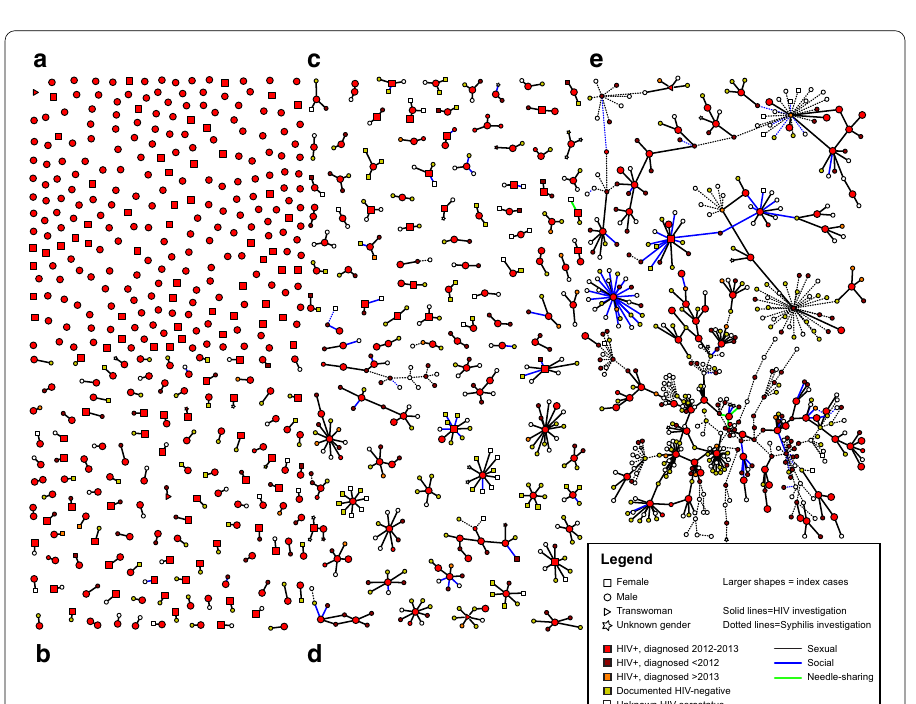
Fig. 2 a. Sociosexual network (N 1470). Sociosexual network showing 569 index cases newly diagnosed = with HIV in the area around Raleigh, North Carolina, during 2012–2013. Total graph includes 1470 persons distributed in 468 network components. Graph shows gender (node shape), HIV status (node color), HIV index case status (node size), type of contact (edge color), and whether the contact was part of an HIV or syphilis investigation (edge thickness). Graph is loosely grouped by size of sociosexual network component: a isolates (n 248 people), b dyads (n 238 people distributed across 119 components), c components size = = 3–4 (n 224 people distributed across 68 components), d components size 5–16 (n 241 people distributed = = across 29 components), and e) components size 26, 81, 92, and 320 (n 519 people distributed across = 4 components). b. Three largest components of the sociosexual network (n 493). Legend: Sociosexual = network showing the three largest components representing 493/1,470 (34%) network members (from left to right, 320, 92, and 81 people, respectively). Graph shows gender (node shape), HIV status (node color), index case status (node size), type of contact (edge color), and whether the contact was part of an HIV or syphilis investigation (edge thickness). The middle component (n 92 nodes) would have been observed = as six smaller HIV investigation components (indicated by gray background) without inclusion of the syphilis investigation partnerships bridging the relationships elicited during the HIV